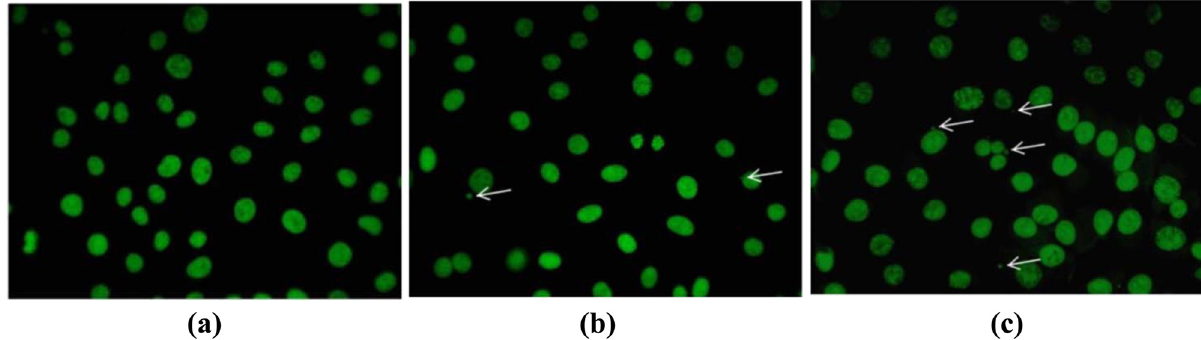
Figure 5: Snapshots of MN formed in untreated MRC - 5 cells ( a ) and upon their treatment with TecAn ( b ) and PenAcAg ( c ) for 48 h.